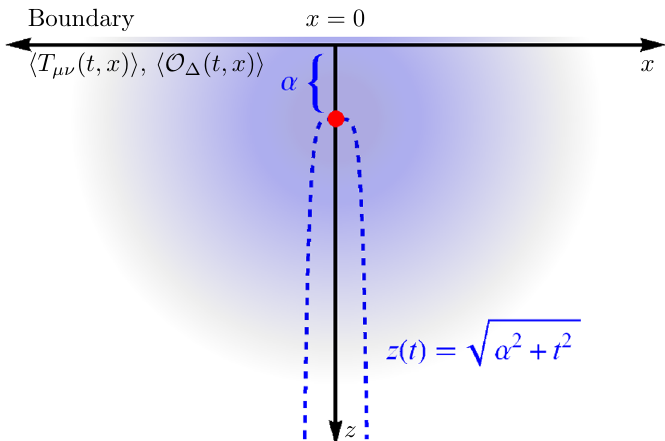
Figure 4 . Schematic representation of the holographic dual of a local quantum quench. The model consists of a small perturbation that arises by acting locally with an operator O (cid:1) on the vacuum state. The perturbation falls into the AdS interior and excites the metric and other bulk (cid:12)elds. The asymptotic values of the metric and scalar (cid:12)eld determine the one point function of the stress- energy tensor T (cid:22)(cid:23) and the scalar operator O (cid:1) in the boundary CFT. For (cid:12)nite (cid:11) , the state at t = 0 can be prepared by smearing the operator over a region with (cid:12)nite support (cid:24) (cid:11) . This is consistent with the standard notion of UV/IR